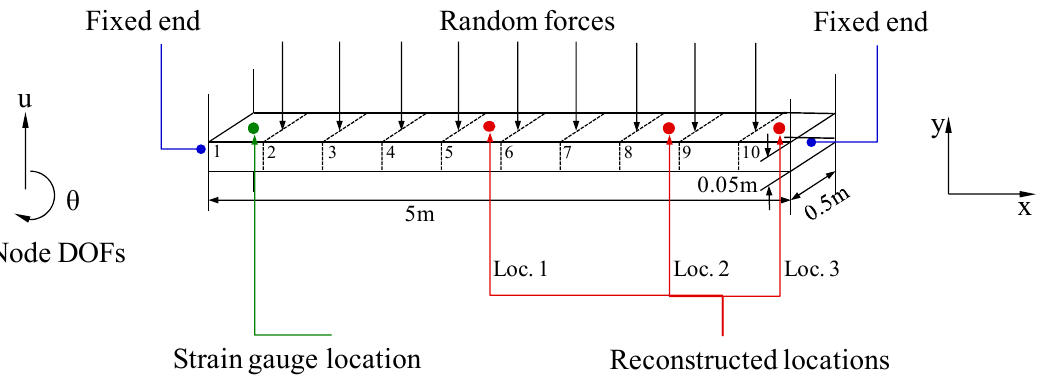
Figure 2. FE diagram of a beam structure with both ends fixed and applied forces. Synthesized strain measurement locations and the three reconstructed locations are the geometry centers of the surfaces of elements 1, 5, 8, and 10, respectively.